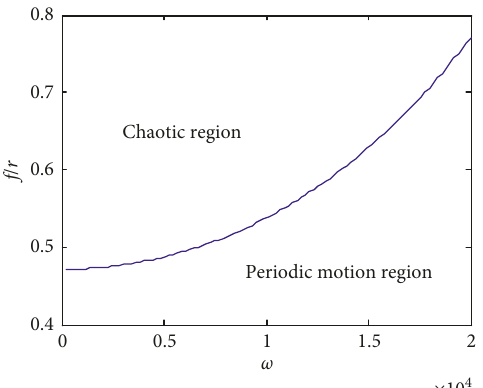
Figure 15: Melnikov function threshold curve of rotor bearing system of motorized